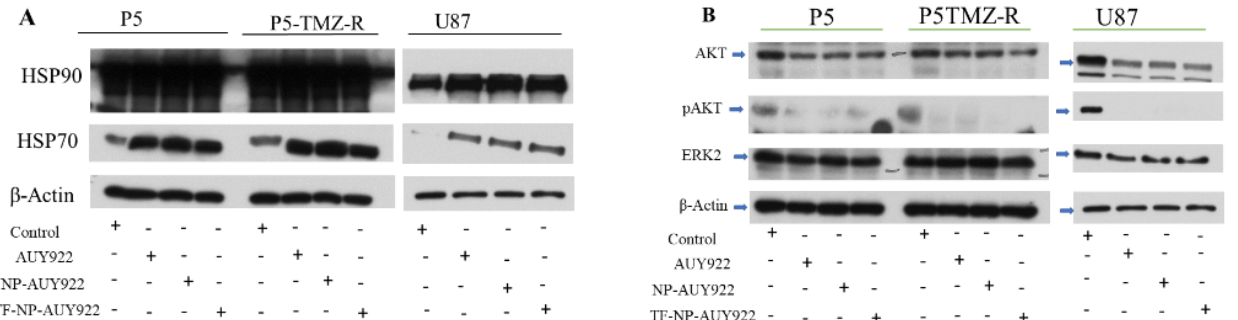
Figure 7. ( A ) Expression levels of HSP90, HSP70, and β -actin proteins ( B ) expression of AKT, pAKT, ERK2, and β -actin proteins in P5, P5-TMZ-R, and U87 brain cancer cells after treatment for 48 h using 100 nM free AUY922, NP-AUY922, and TF-NP-AUY922. In ( A ), the actin in the P5/P5-TMZ-R part of the experiment is identical as shown in Figure 5B, and the actin in the U87 part of the experiment in both ( A , B ) are the same, which was identical as shown in Figure 5B, because they are part of the same original blots probed with different antibodies of interest. The figures are re-organized as presented to better align with the data demonstrated in the Results section.